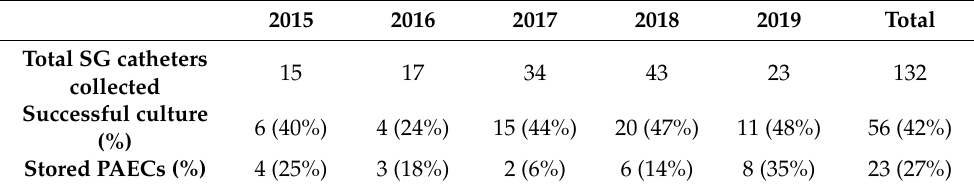
Table 2. Summary of total collected catheters and successfully stored